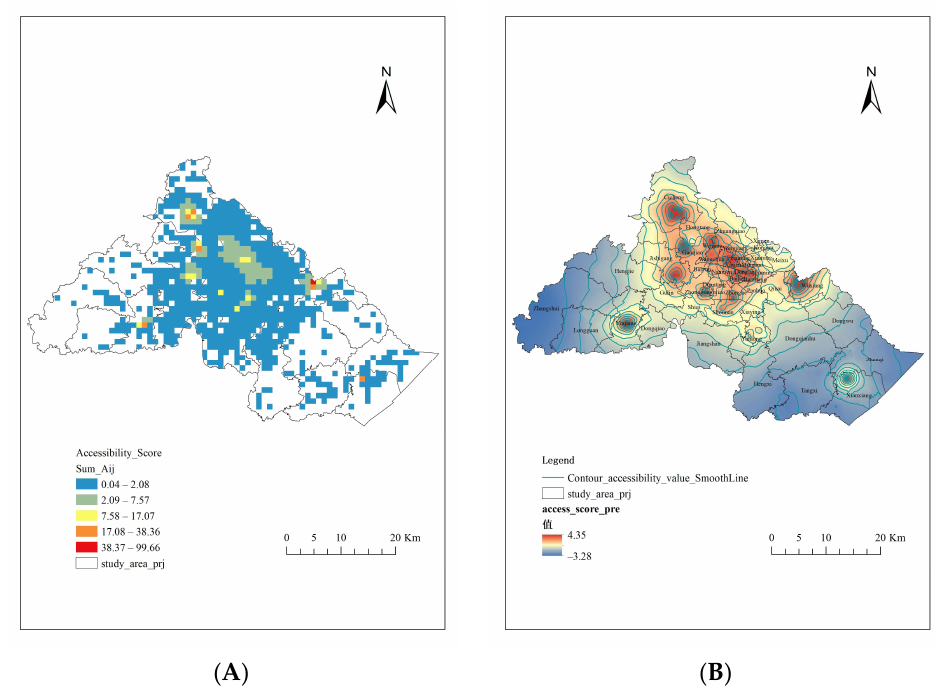
Figure 8. ( A ) The elderly’s spatial accessibility scores of demand points; ( B ) Spatial equilibrium of the elderly’s spatial accessibility in the total study area. Table 5. Accessibility scores of different demand points.